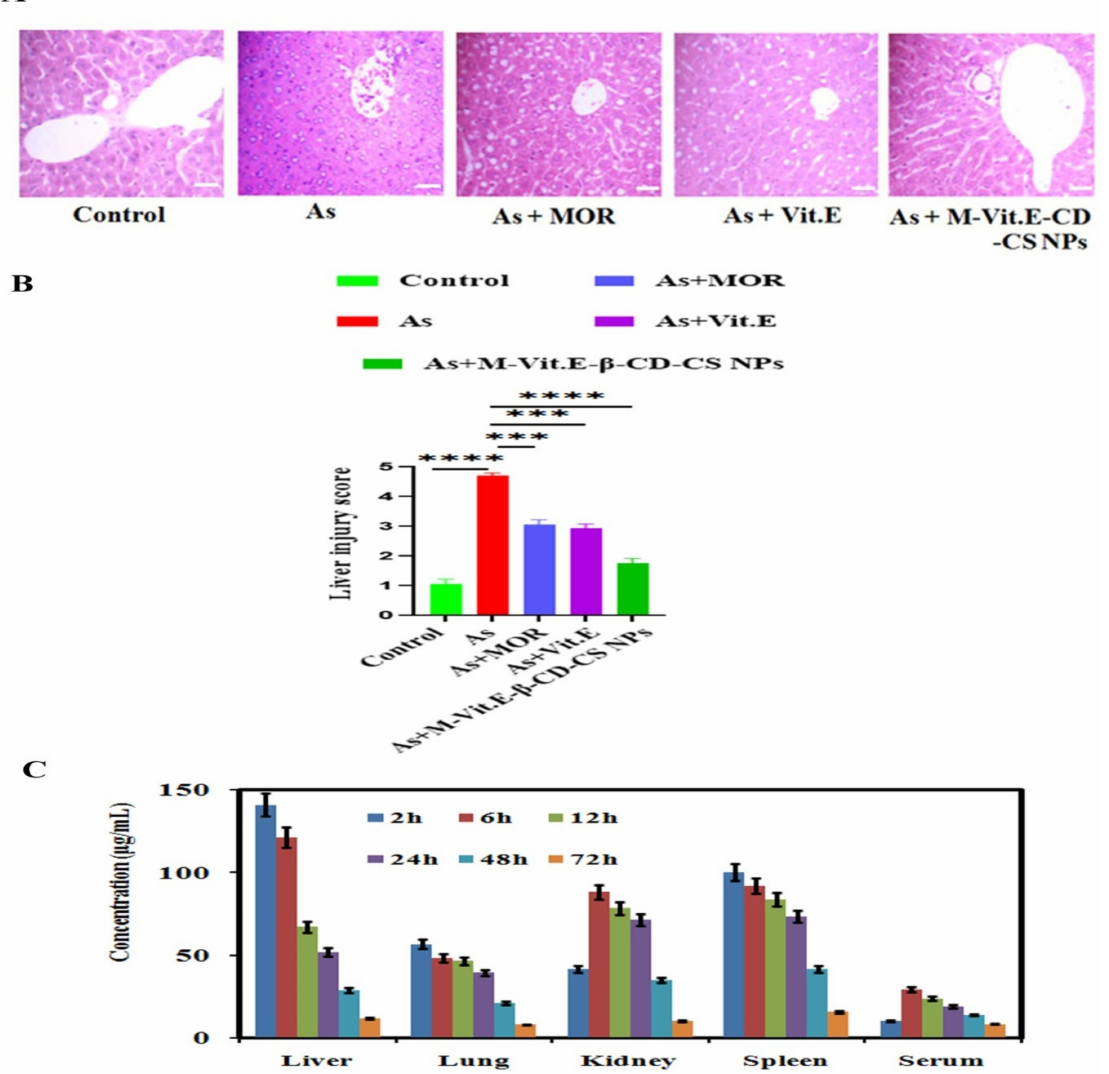
Figure 8. ( A ) Effect of MOR, vitamin E, and M-Vit.E-CD-CS NPs on liver tissue histology architecture of liver tissue section, following treatment without or with MCNPs and MOR in arsenic-exposed mice (Scale bar 100 microns). ( B ) Histopathological scoring of the liver tissue (*** p , 0.001, **** p , 0.0001). ( C ) Tissue distribution studies of M-Vit.E-CD-CS NPs in various organs. Mean concentration of Morin in liver, lungs, kidneys, spleen, and serum at 2, 6, 12, 24, 48, and 72 h after oral administration of single dose of M-Vit.E-CD-CS NPs ( n = 3, mean ± SD) in mice. 2.10. Tissue Distribution Study of M-Vit.E-CD-CS NPs in Various Organs A single dose of M-Vit.E-CD-CS NPs orally given to the mice for several time points and the concentration of Morin and vitamin E in liver, spleen, lungs, kidneys, and